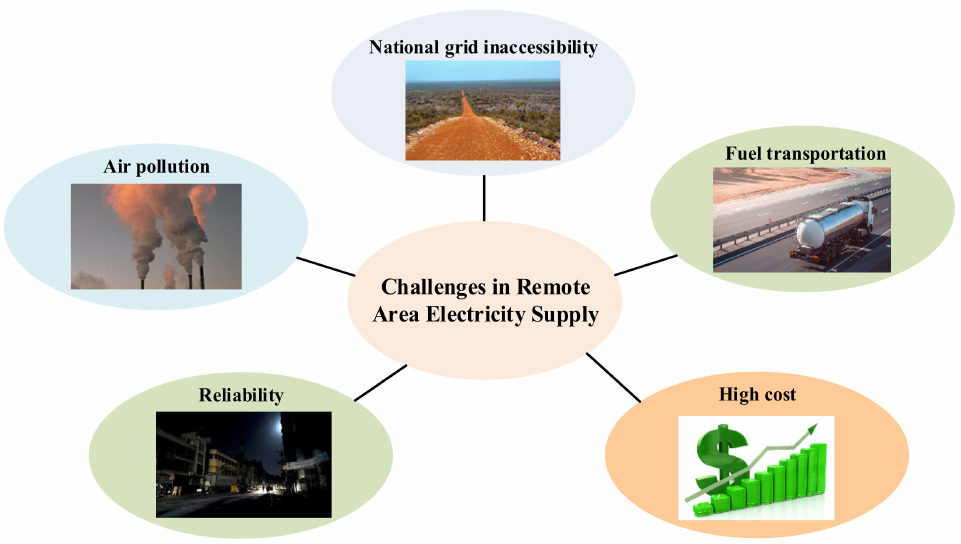
Figure 2. Electricity supply challenges in remote